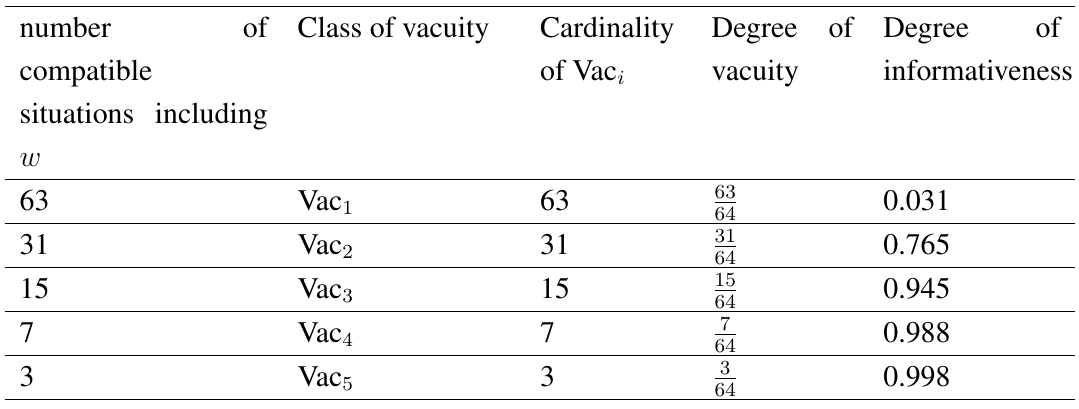
Table 2. Classes of